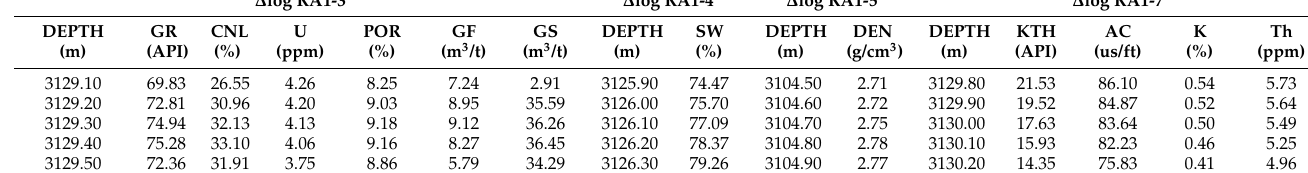
Table 12. Actual logging data corresponding to ∆ logR1-3, ∆ logR1-4 ∆ logR1-5, and ∆ logR1-7 in C1 well. ∆ log